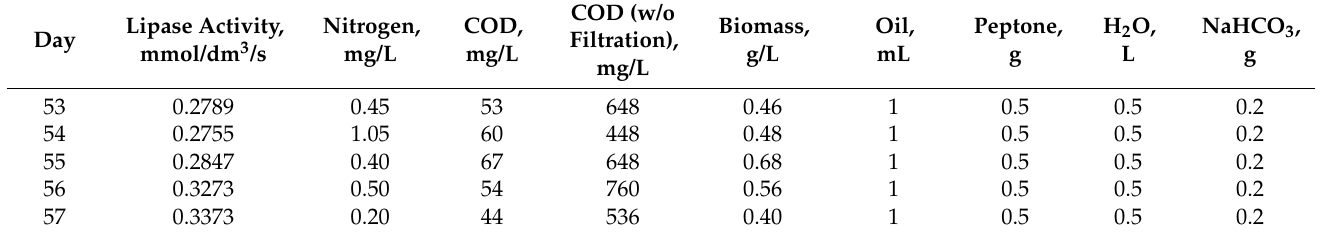
Table 2. Continuous-flow reactor measurements between day 53 and day 57.